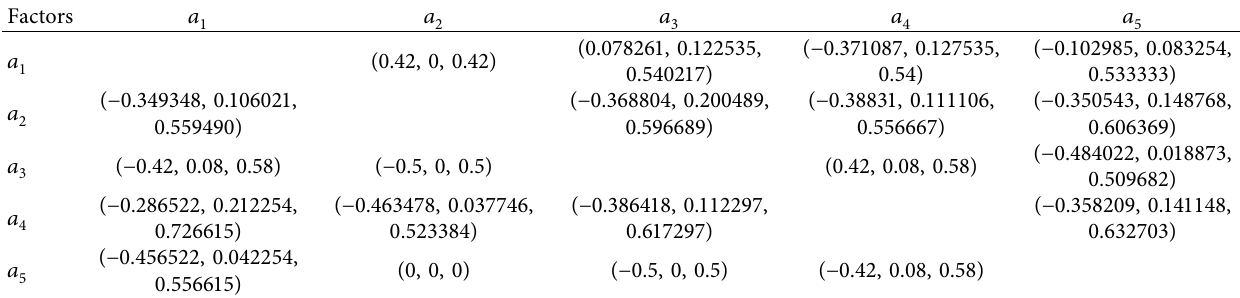
Table 14: Preference index value.